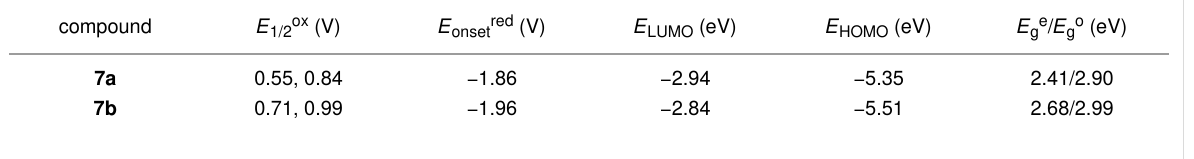
Table 2: Oxidation, reduction and energy gap of compounds 7a and 7b .